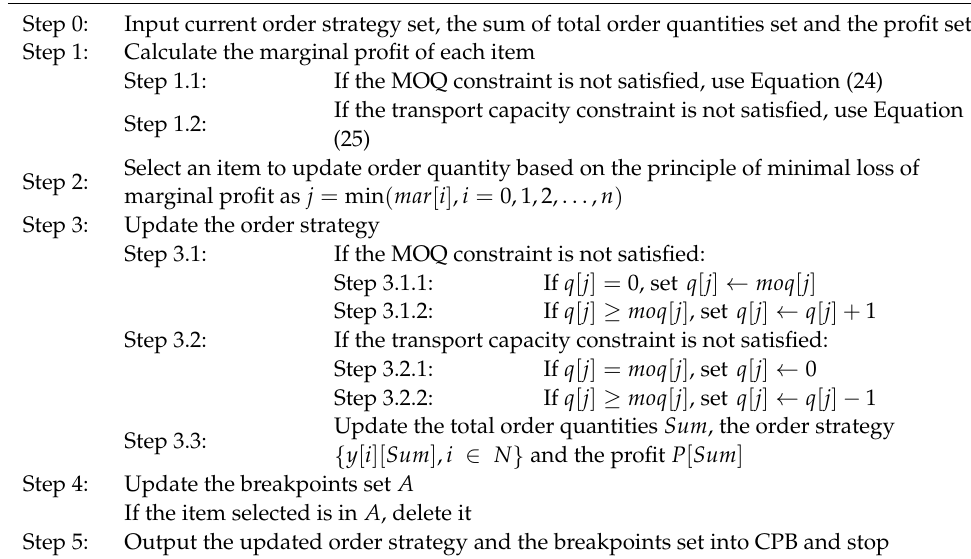
Algorithm 1. Process of Marginal Profit-Based Algorithm